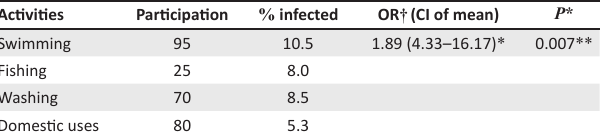
TABLE 4: Distribution of Schistosoma haematobium infection by freshwater contact activities ( n = 270), Nigeria, December 2016.